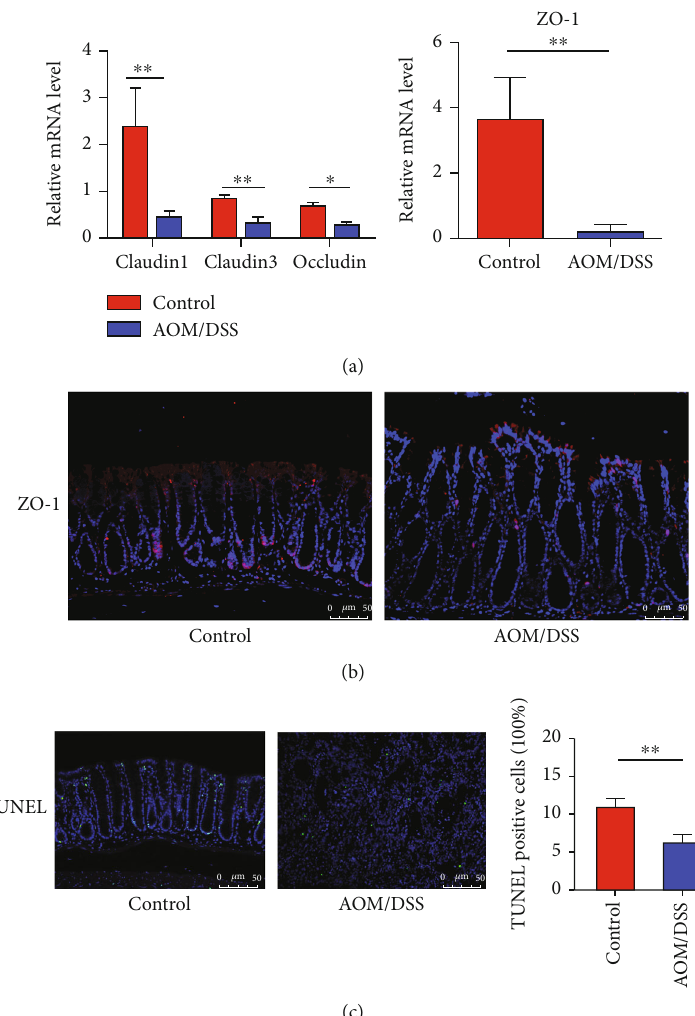
Figure 2: Intestinal barrier was disrupted in the CAC model. (a) The mRNA level of Occludin, Claudin1, Claudin3, and ZO-1 was reduced in the colon after AOM/DSS treatment. (b) Immuno fl uorescent staining for ZO-1 in colon tissues of the control and AOM/DSS group. (c) Colon sections from the two groups were stained with TUNEL. Data were quanti fi ed as the mean percentage of positive-stained cells in fi ve randomly selected fi elds in each sample. Scale bars, 50 μ m. ∗ p < 0 : 05 , ∗∗ p < 0 : 01 . n = 8